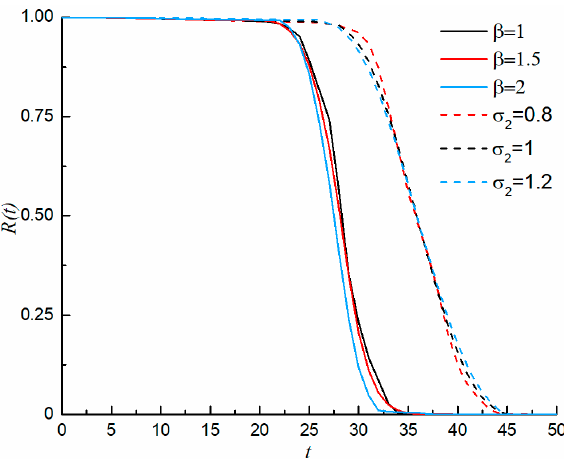
Figure 8. Reliability curves with varying di ff usion parameters of the second Wiener process and varying scale parameters of the gamma process.